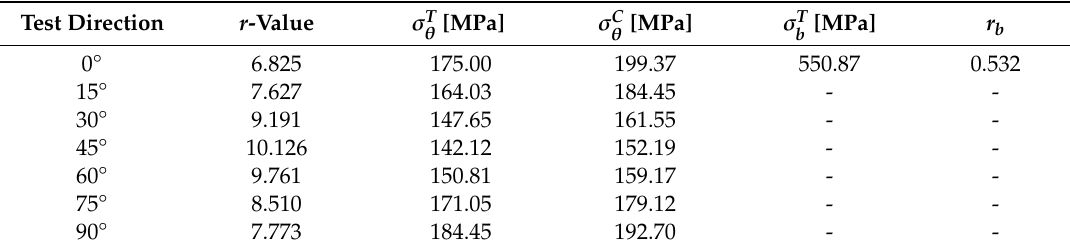
Table 10. Data for the Zirconium plate for equivalent plastic strain of 15%, adapted from [35], with permission from Elsvier, 2006.